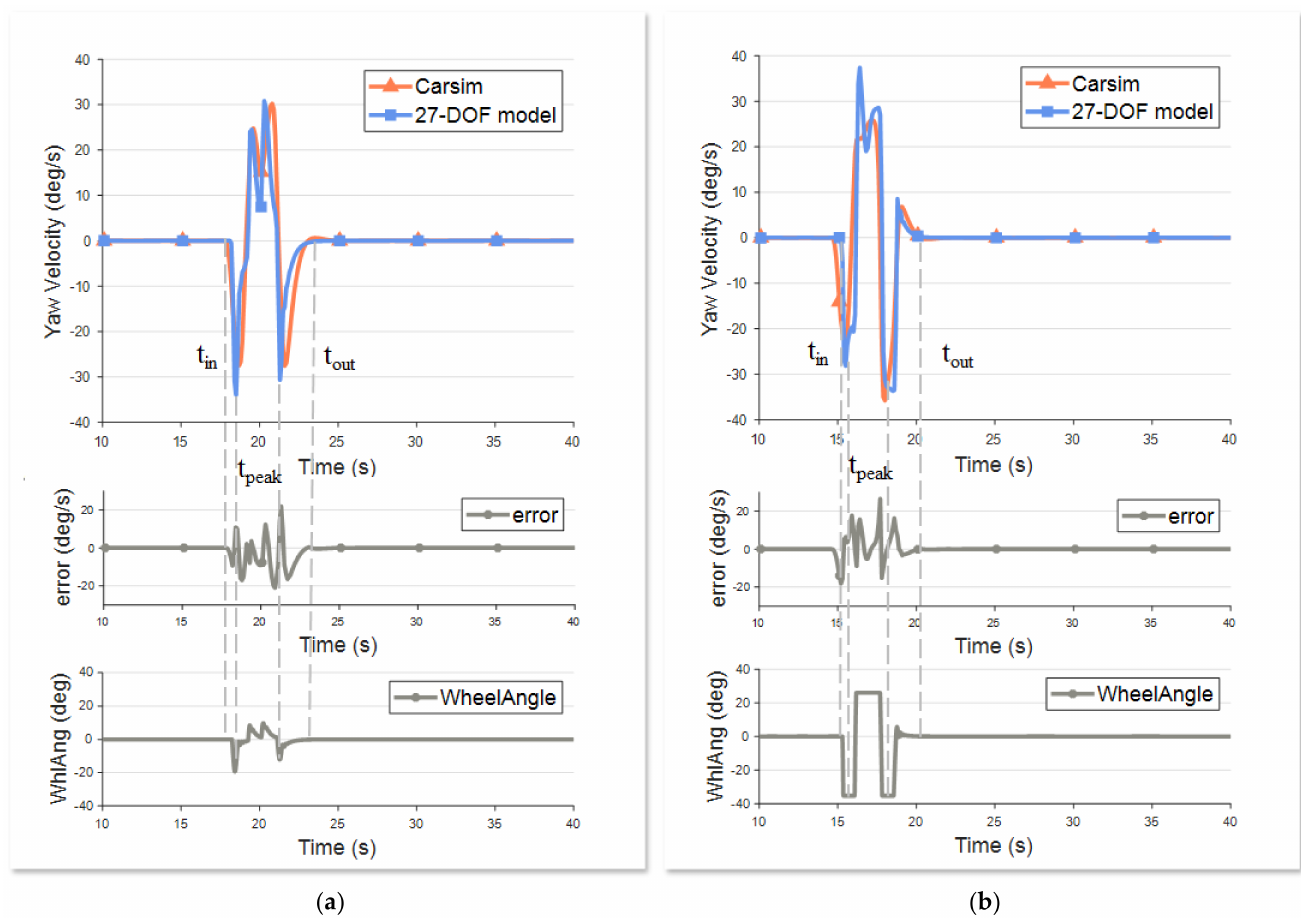
Figure 8. Yaw Velocity in the double lane change scenario of unsaturated steering and saturated steering. ( a ) Unsaturated Steering. ( b ) Saturated